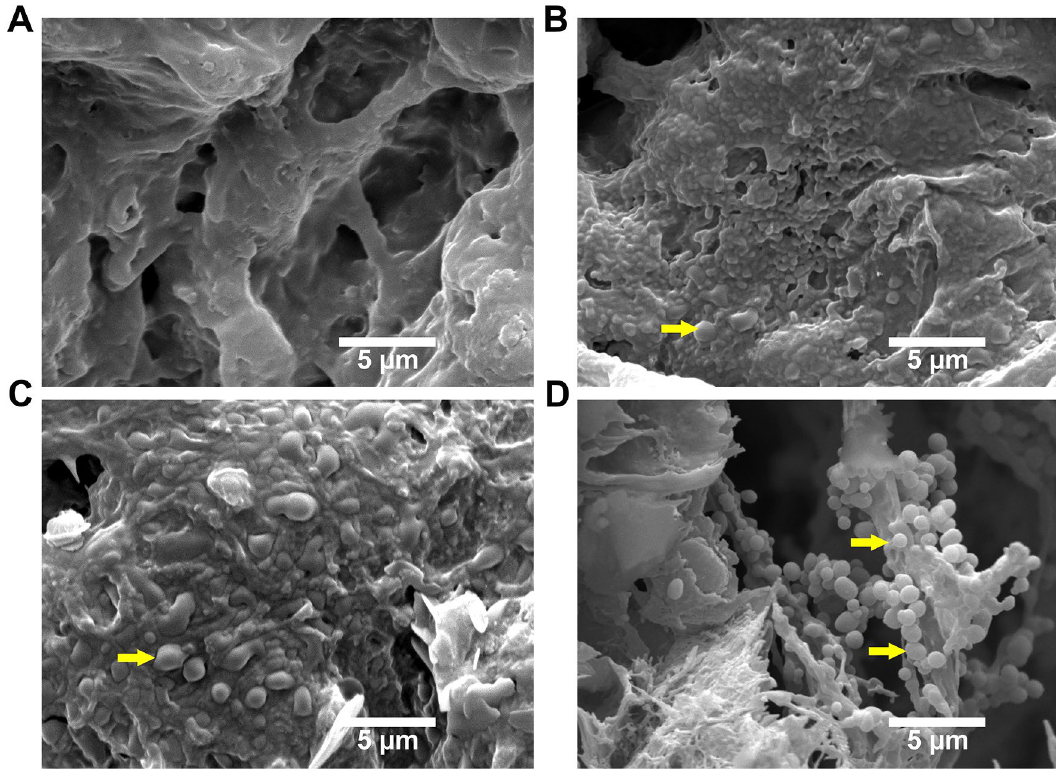
Figure 5. SEM images exhibit cross-sectional morphologies of ( A ) PVA, ( B ) PVA-K0.1, ( C ) PVA-K0.25, and ( D ) PVA-K0.5 hydrogels. The arrows refer to the kaolin particles inside the hydrogels, indicting the variations on the basis of kaolin content.